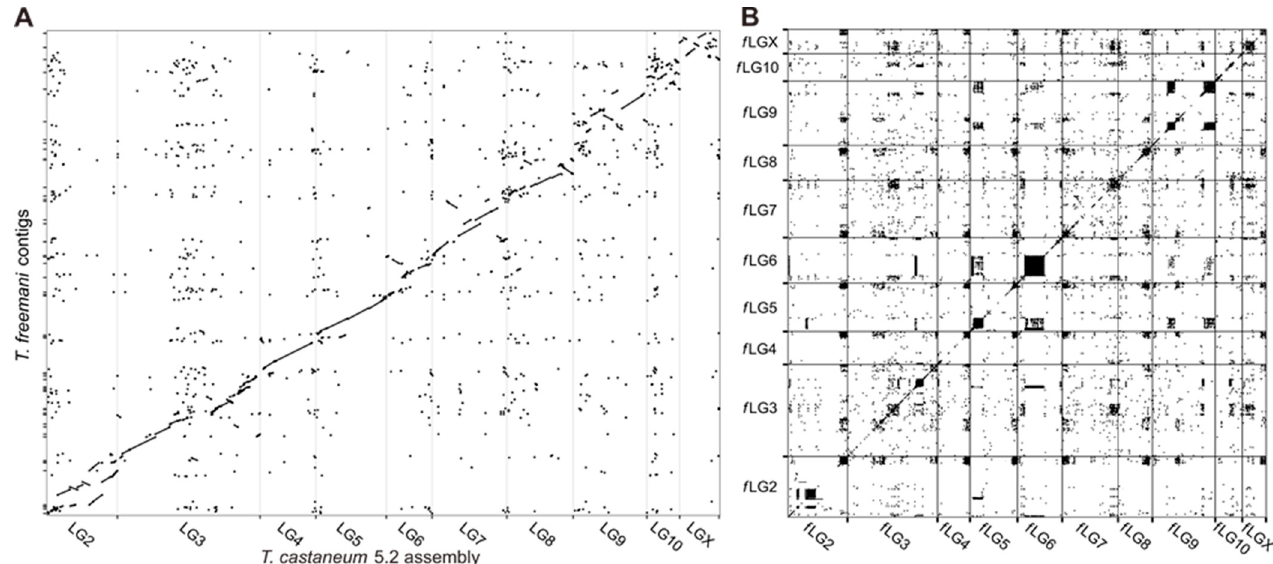
Figure 2. Dot plot visualization of genome-to-genome alignment produced with dotPlotly. ( A ) Com- parison of T. freemani contigs with 10 linkage groups (LGs) representing chromosomes in the T. castaneum reference assembly Tcas5.2. ( B ) A self-to-self alignment of T. freemani assembly Tfree1.0. Abbreviations f LG stand for T. freemani linkages groups obtained by the reference-guided orientation of contigs.